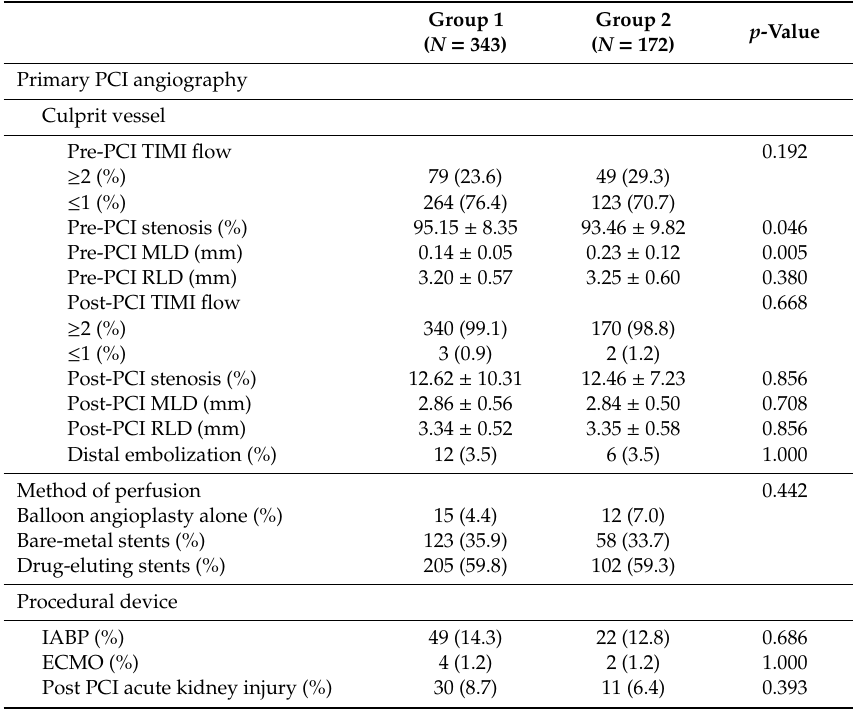
Table 2. Angiographic characteristics of study patients.